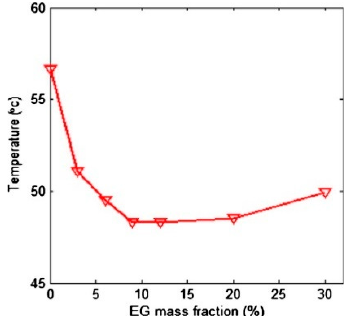
Figure 1. The volume-averaged battery temperature as a function of EG mass fraction.